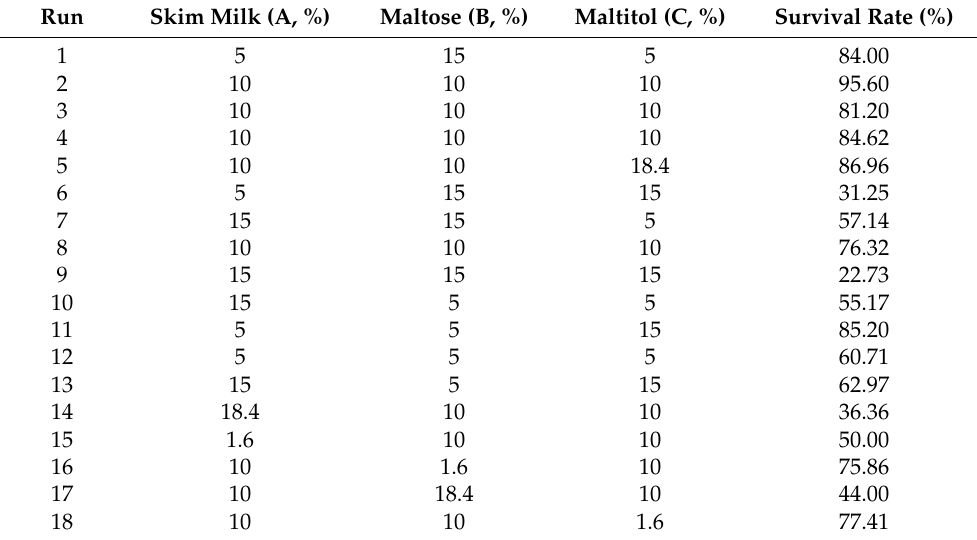
Table 3. Central composite design for the composite protectant of S. cerevisiae 88-4. Run Skim Milk (A, %) Maltose (B, %) Maltitol (C,